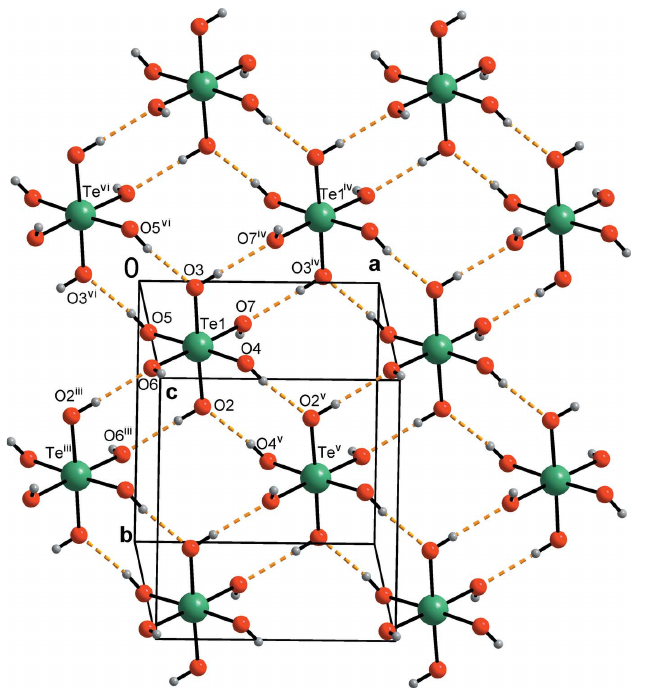
Table 2). The other primary amine hydrogen atom, H2 N 2,